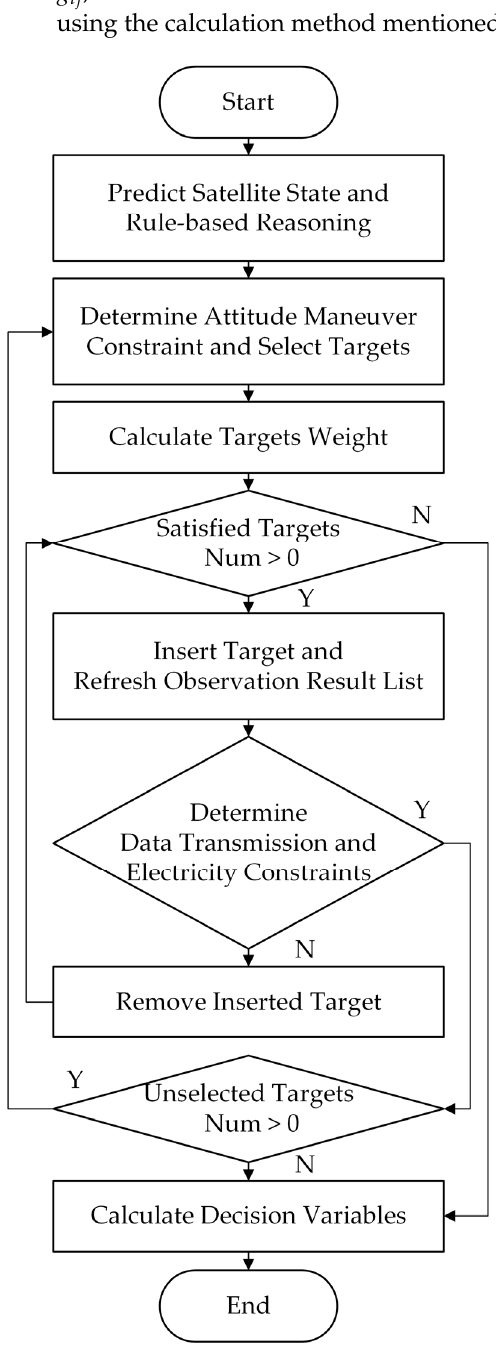
Figure 6. Flowchart of RS.